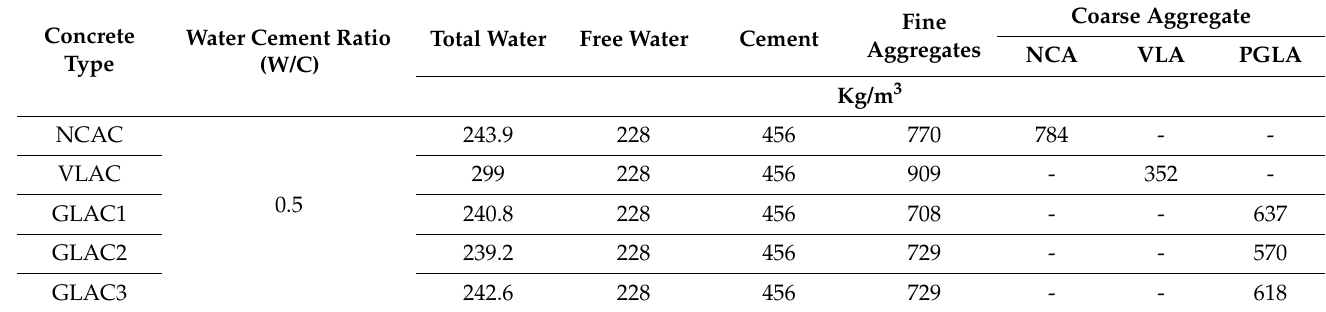
Table 2. Mix quantities per m 3 for different mixes.